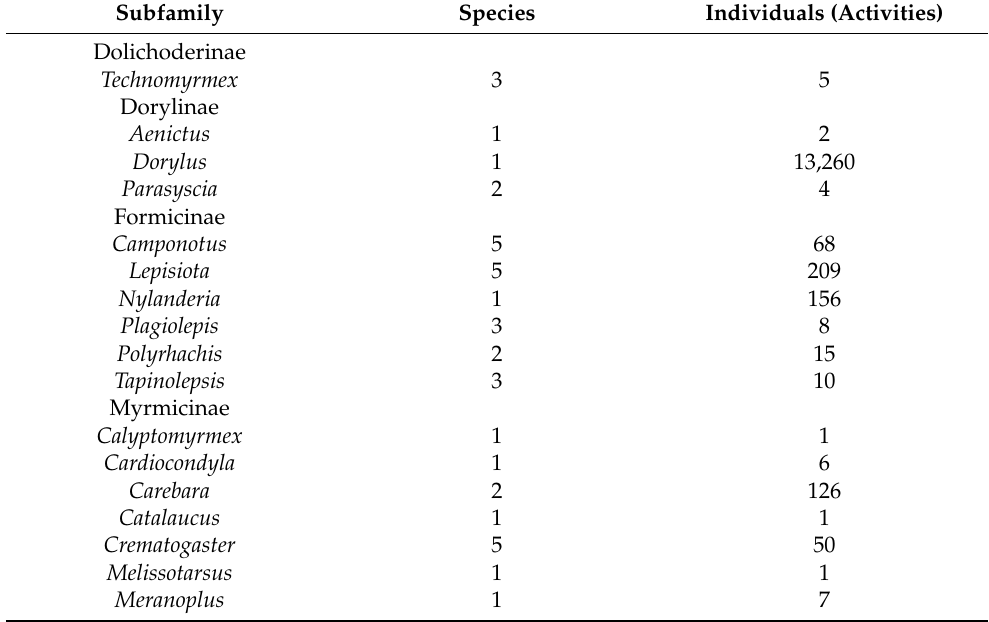
Table 2. Number of genera, species richness, and individuals (activities) of ant subfamilies collected in the